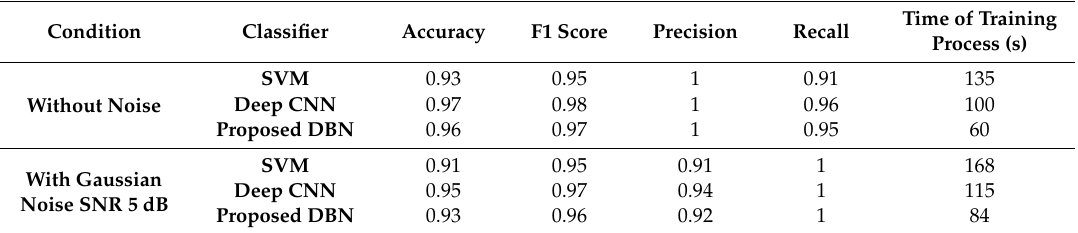
Table 5. Comparison of recent smoke detection methods for the studied video set with noise and without